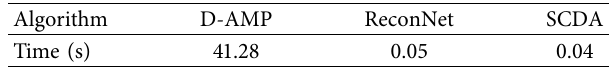
Table 9: The number of network parameters for 10 images (the measurement rate is 0.20).